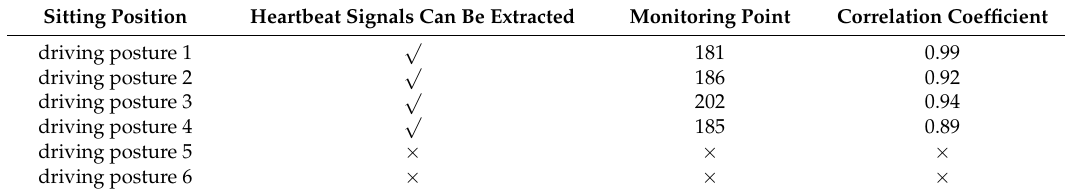
Figure 14. Correlation coefficient analysis in varied driving postures. Table 2. Measuring point optimization selection.